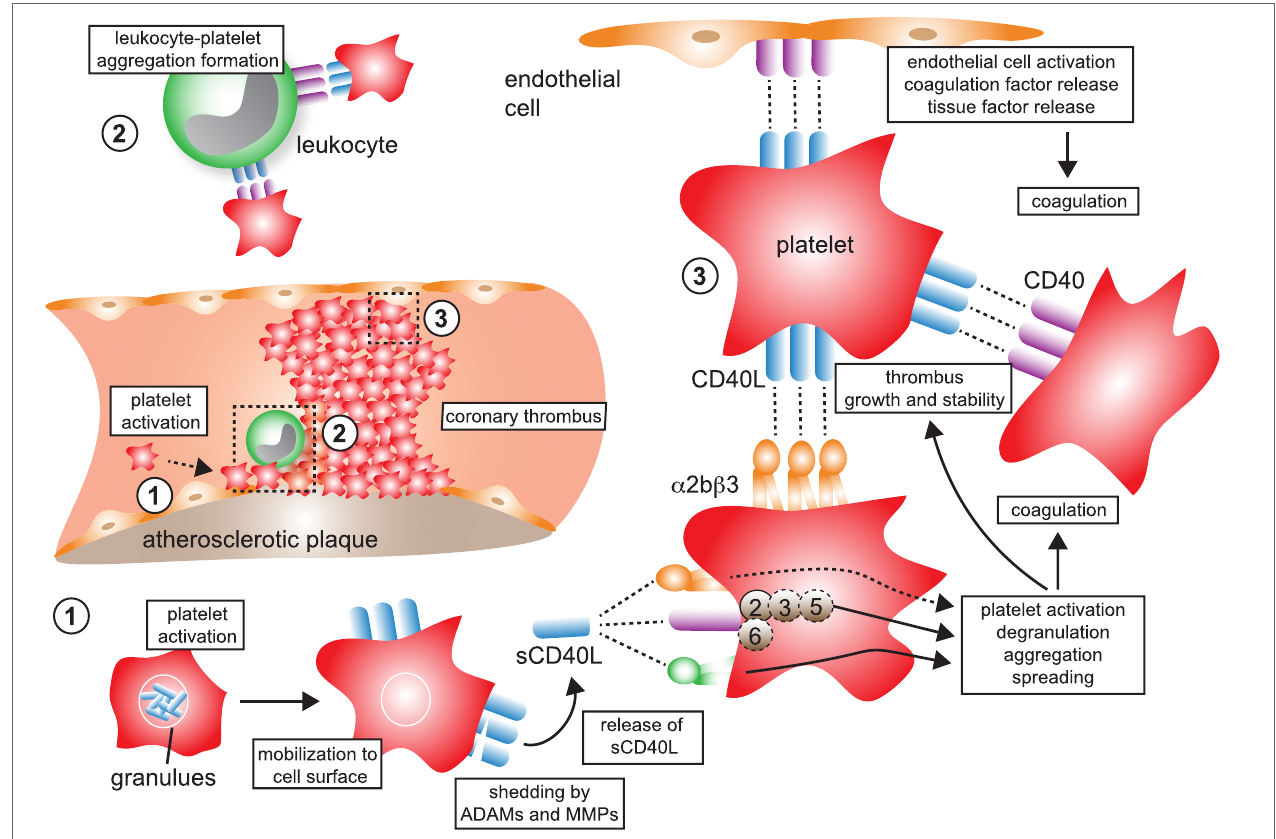
FigURe 4 | CD40L and its receptors in thrombosis and hemostasis. (1) Monomeric CD40L is stored in α - and dense granules of platelets. Upon platelet activation and degranulation, CD40L is mobilized to the cell surface and forms biologically active trimers. These are shed within minutes to hours by ADAMs and matrix metalloproteinases (MMPs) and released as monomers of soluble CD40L (sCD40L). These have been reported to form dimers and trimers in circulation that a biologically active. (2) Platelet-expressed CD40L binds to its receptors on leukocytes, α 5 β 1 and CD40, but not α M β 2 (Mac-1), to form platelet–leukocyte aggregates. Notably, platelet-expressed CD40 can bind to CD40L-expressing leukocytes, such as activated T cells. (3) Ligation of platelet-expressed receptors, α 5 β 1 and CD40, by CD40L initiates platelet activation cascades that eventually result in the surface expression of platelet receptors, such as P-selectin, degranulation, aggregation, and spreading. CD40 ligation on platelets activates a TRAF-2 dependent, but not TRAF-6 dependent, signaling pathway. It is a controversy whether ligation of α 2b β 3 by CD40L participates in platelet activation. However, physical interactions between platelet-expressed α 2b β 3 and CD40L, as well as between CD40 and CD40L, help to stabilize platelet aggregates and fuel thrombus growth. Binding of platelet CD40L and of sCD40L to its endothelial receptors CD40 and α 5 β 1 promotes endothelial cell activation, pro-inflammatory gene expression, and secretion of coagulation factors, including tissue factor, which in turn can amplify thrombosis and